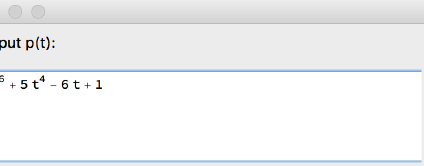
Figure 36. Part of the structure of the [ARoots] algorithm corresponding to Option 1 to input p . The algorithm gives the roots in T , T + , and T − (Figure 37).